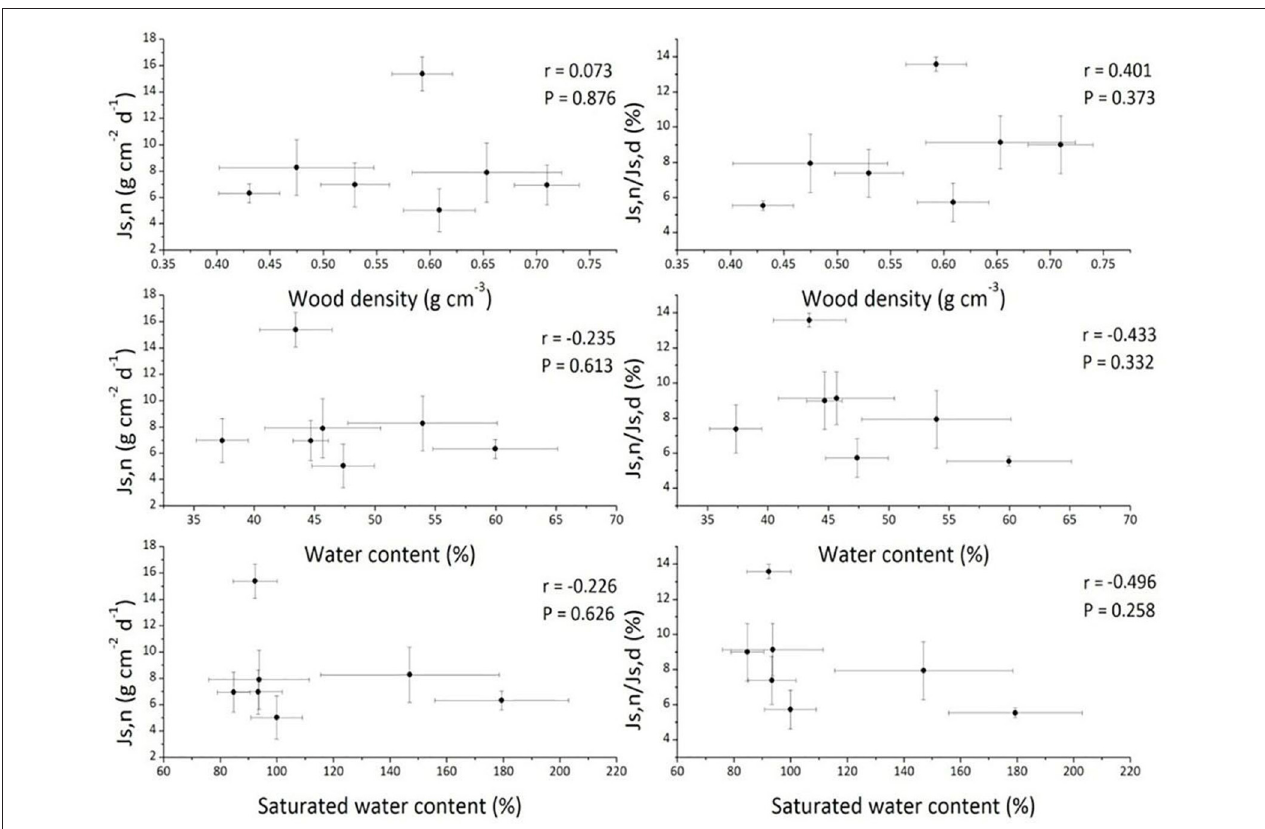
FIGURE 4 | The nighttime sap flux ( J s,n ) and the ratio of nighttime to daytime sap flux ( J s,n / J s,d ) vs. wood density, wood water content, and saturated wood water content across the seven studied tree species. Data are means ± SD .